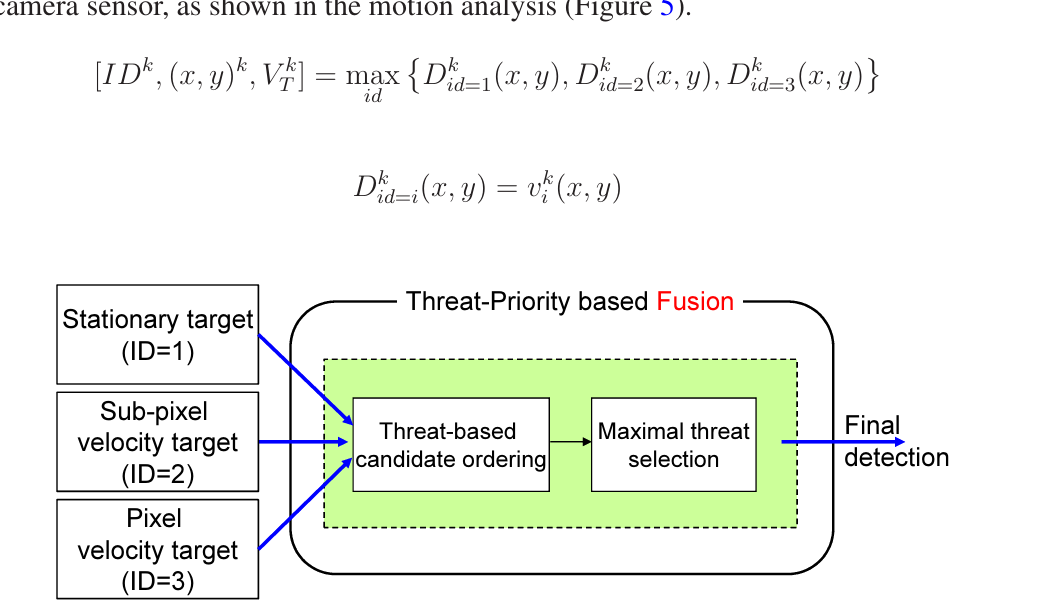
Figure 18. Threat-priority-based detector fusion using threat ordering and max